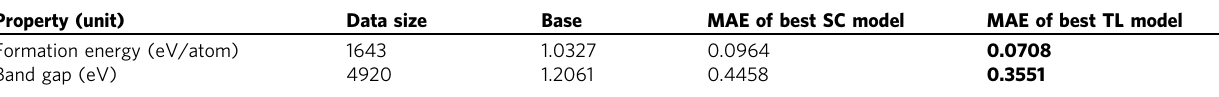
Table 5 Prediction performance benchmarking for the prediction task of “ Transfer Learning on Experimental Data" on the test